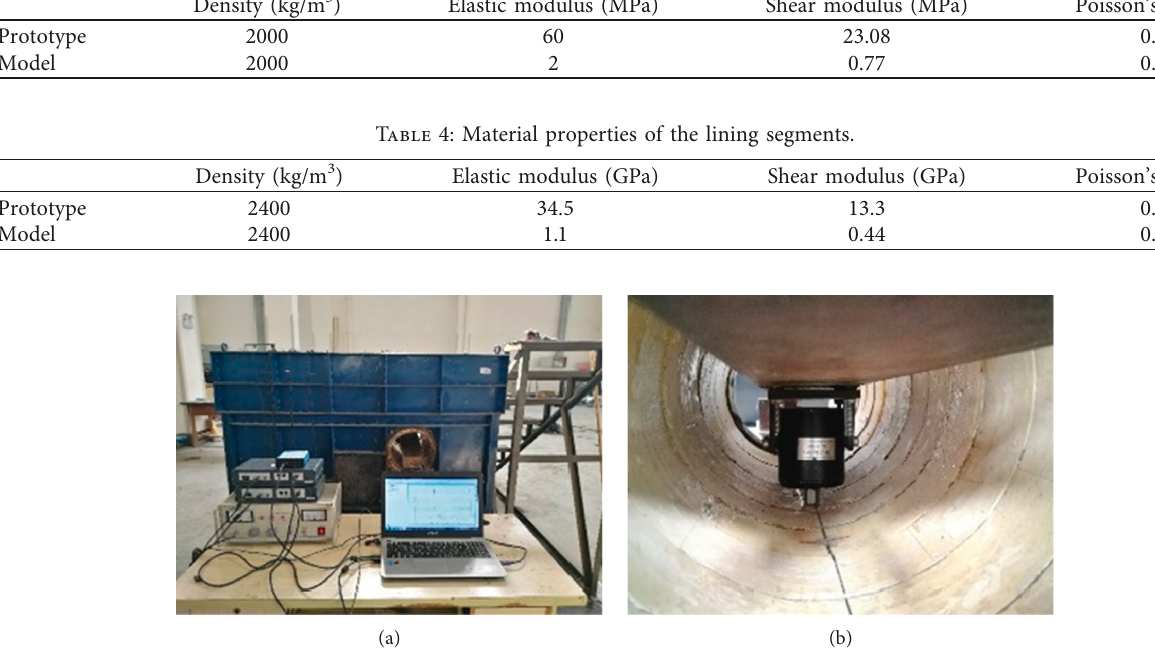
Figure 3: Model test equipment: (a) control system; (b)